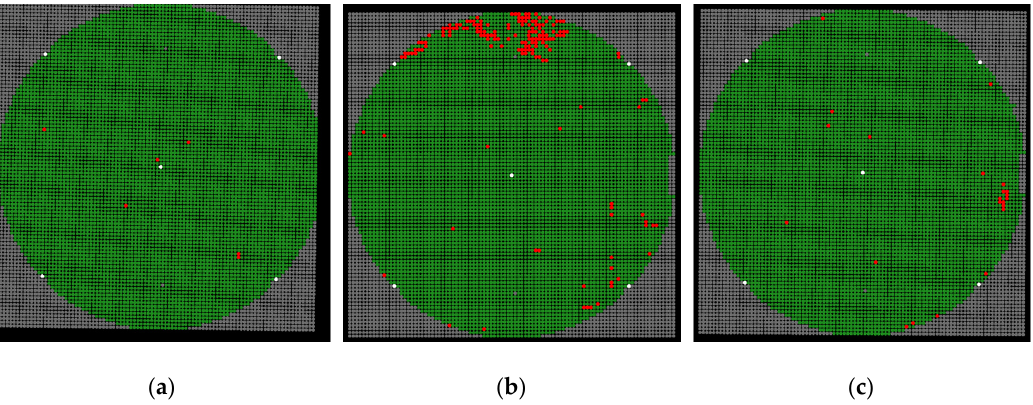
Figure 18. Results of our proposed inspection method for three SAT images: ( a ) img01 ; ( b ) img02 ; ( c ) img03 .